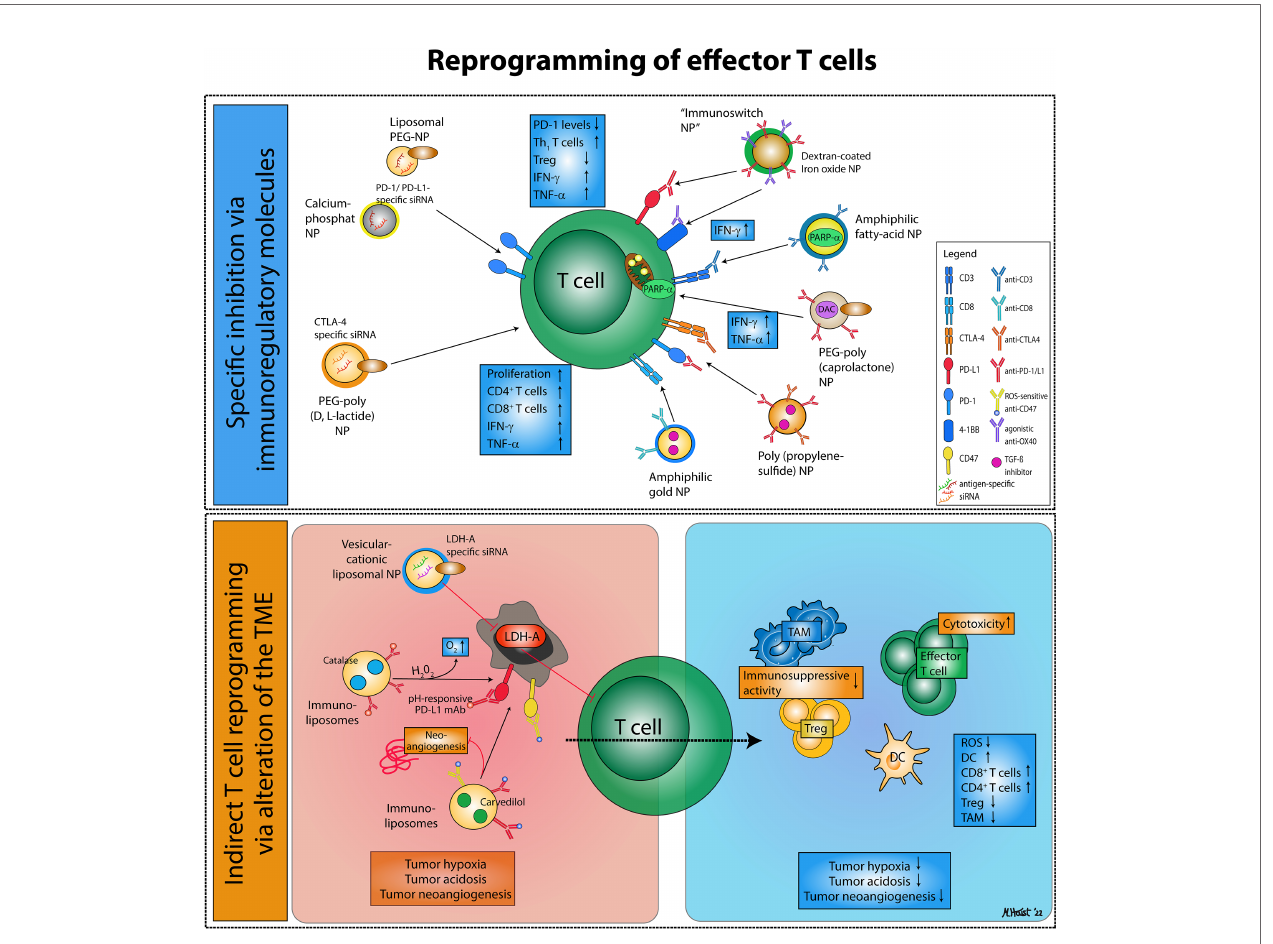
FIGURE 2 | Nanodrug-based approaches for effector T cell reprogramming. Reprogramming of exhausted effector T cells and regulatory T cells via nanodrugs can be distinguished into two major categories: (1) Nanoparticles that speci fi cally inhibit immunoregulatory molecules on effector T cells or regulatory T cells, thereby enhancing effector T cell activity. (2) Nanoparticles targeting immunosuppressive mechanisms characteristic of the tumor microenvironment that favor the accumulation of immunosuppressive cell types and an alleviate an effective anti-tumor immune